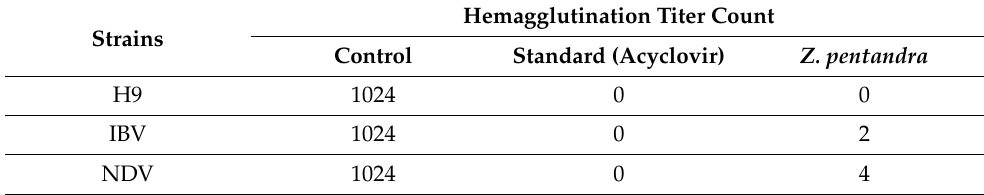
Table 4. Antiviral activity of Z. pentandra